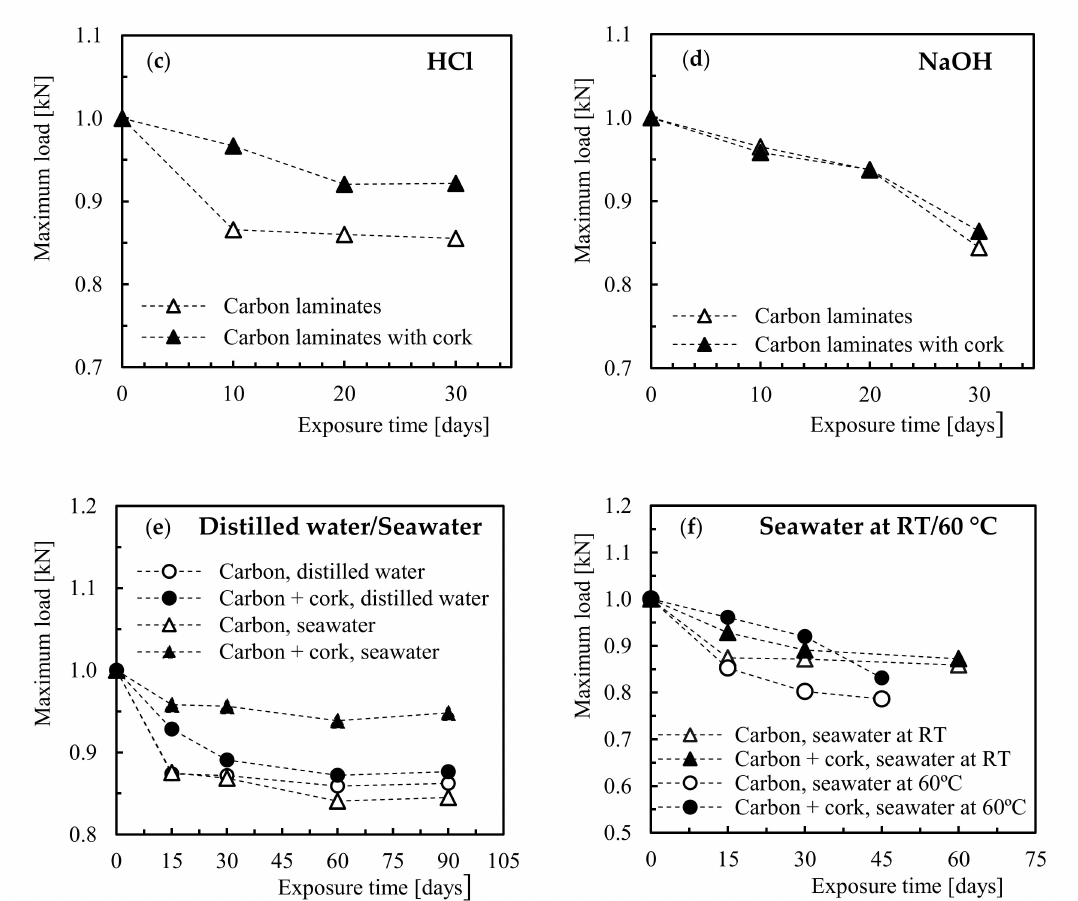
Figure 4. Influence of solution type and exposure time on the maximum impact load after immersion into: ( a ) diesel;